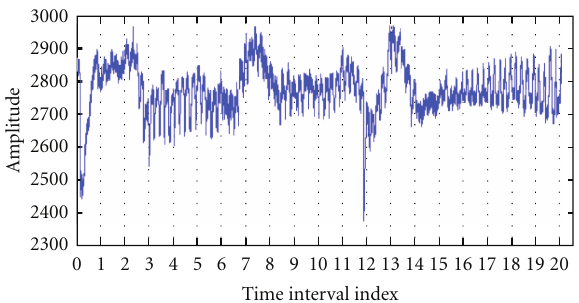
Figure 4: Amplitude of the life signal. The time intervals used in the monitoring are also pointed out.